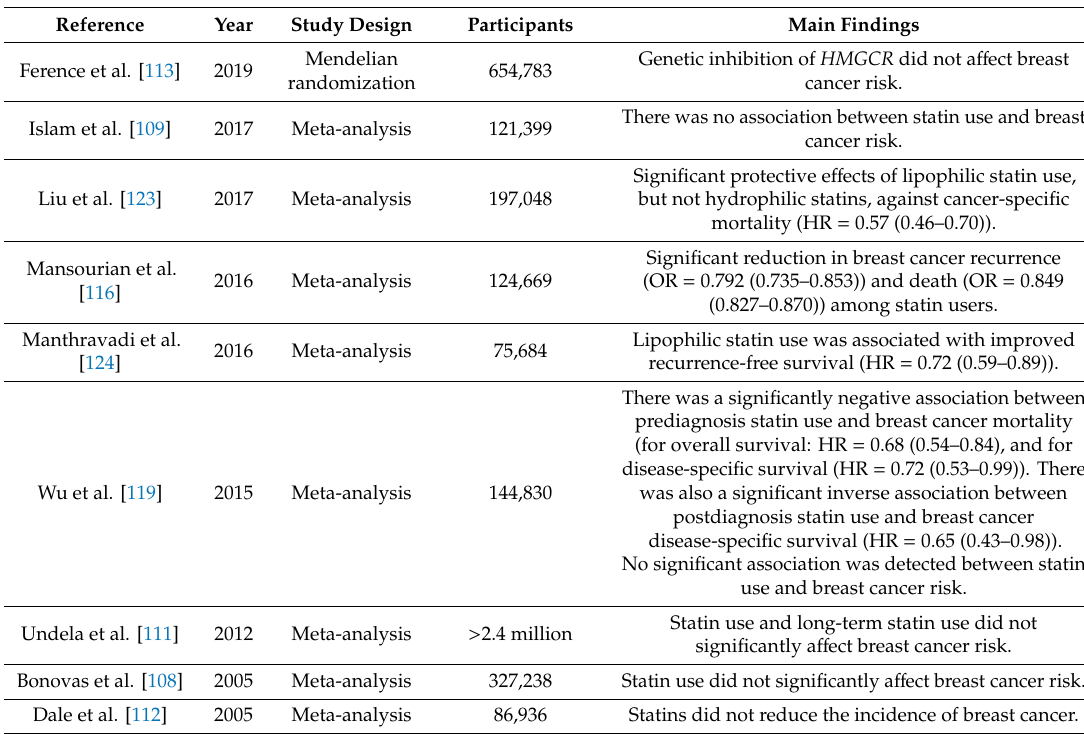
Table 2. Clinical and epidemiological studies linking statin treatment to breast cancer